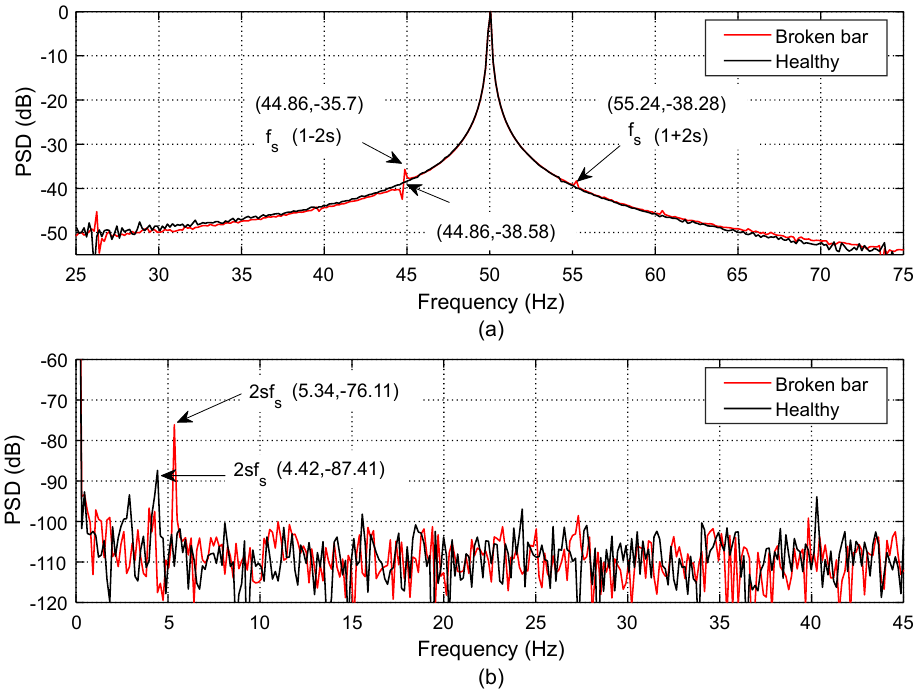
Figure 1. Spectra of the ( a ) stator current and ( b ) mechanical rotor speed of the motor supplied from the voltage source inverter and in stationary